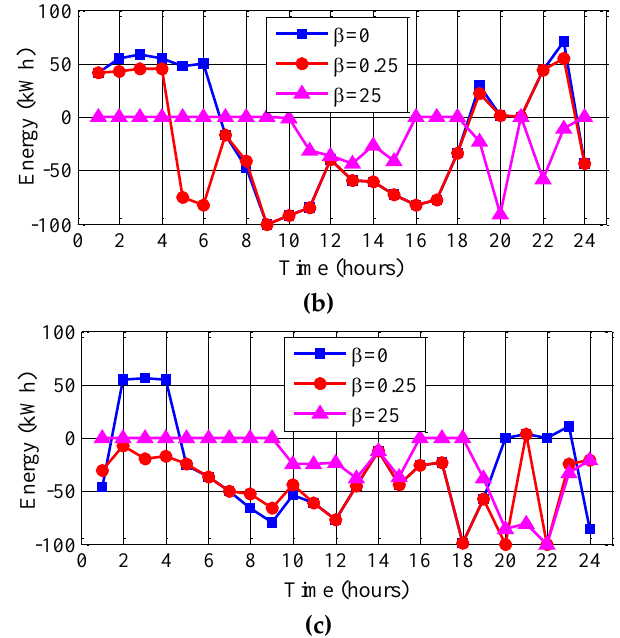
Figure 8. Hourly energy trading between the microgrid and the main grid in different penetration levels of wind power, ( a ) penetration level = 0%, ( b ) penetration level = 50%, and ( c ) penetration level = 100%.